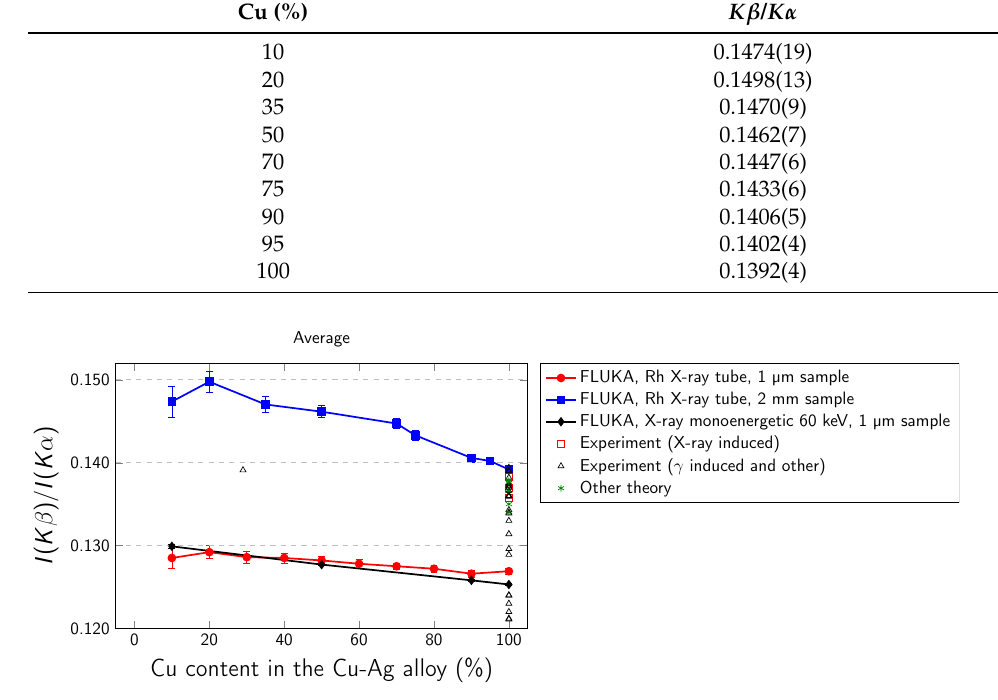
Figure 4. K β / K α intensity ratio arising from the primary X-ray simulated with FLUKA, calculated for average output flux in 1 µm and 2 cm samples.